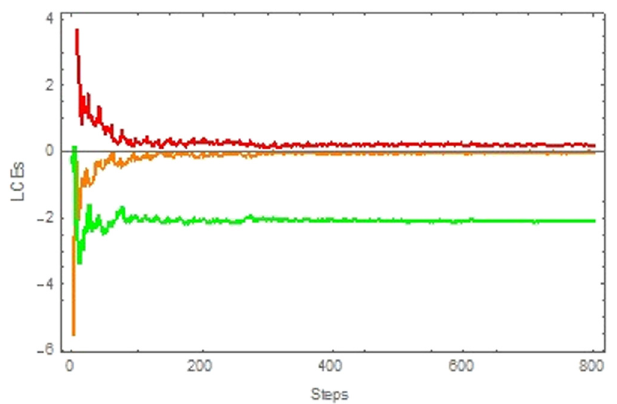
Figure 3: The convergence plot of the LEs for Hide ’ s model with initial conditions and parameter values = { x −0.1, 5.1, 0 } −0.34715835 , = β 2 , = α 20 , = λ 1.2 , = κ 1